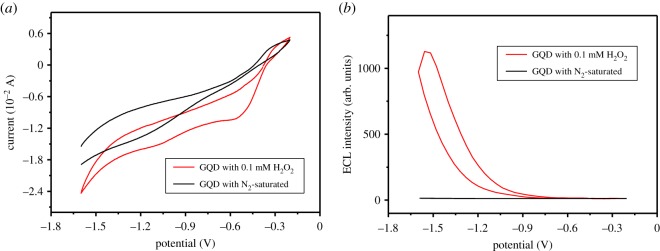
(a) CVs and (b) ECL of GQD on Ti foil in 0.067 mol l−1 pH ∼ 7 PBS with N2-saturated and 0.1 mmol l−1 H2O2.